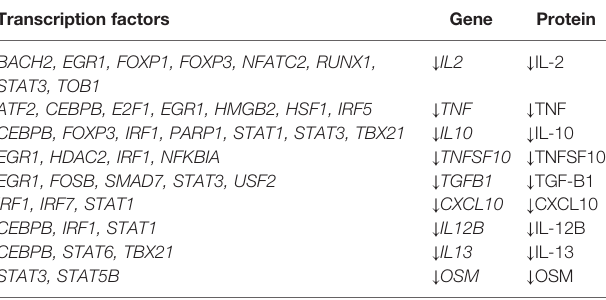
TABLE 1 | Disease-associated genes and proteins and their corresponding transcription factors that are signi fi cantly affected by